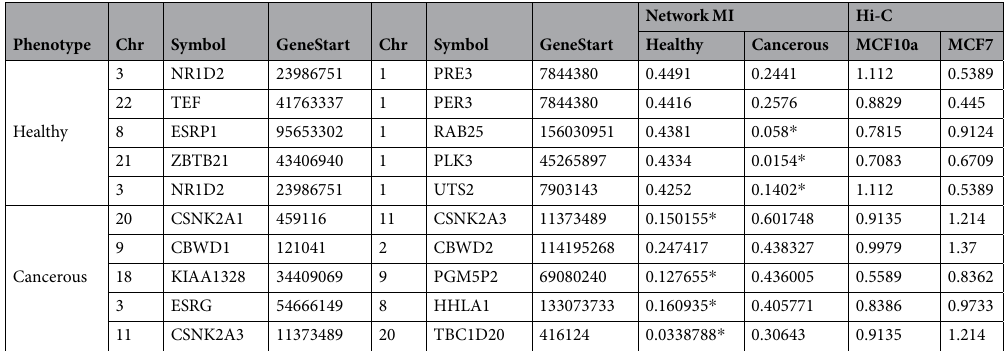
Table 5. Top 5 comparison between inter-chromosomal network interactions and Hi-C experiments for healthy and cancerous data. * Not present at 0.01% MI